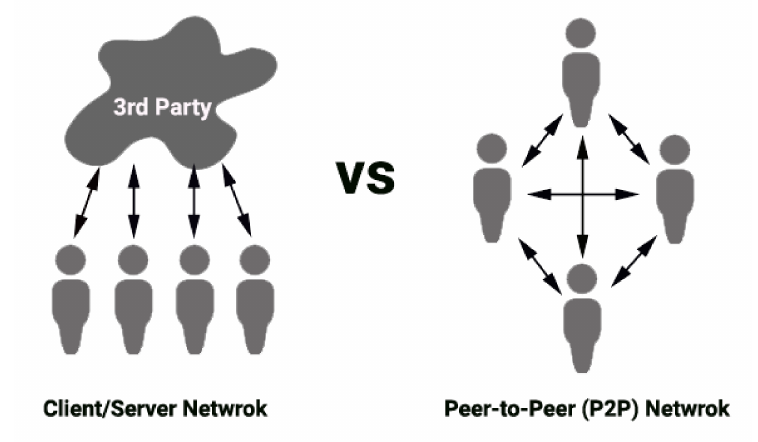
Figure 2. P2P network vs Client/Server